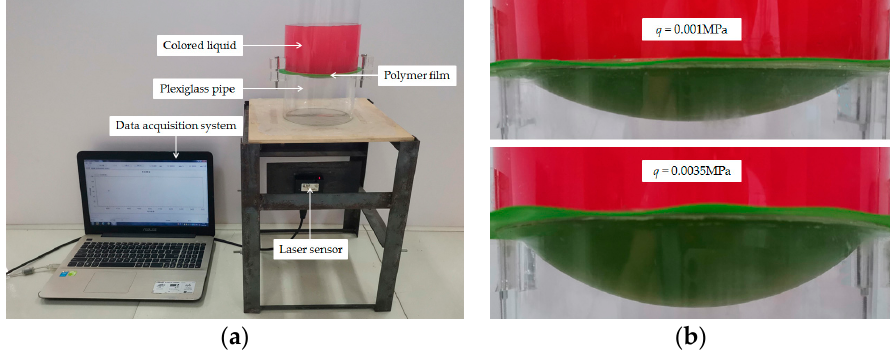
Figure 7. Photographs of an experiment on the large deflection deformation of a polymer thin film: ( a ) Experimental setup; ( b ) The deflected polymer thin film under different loads.